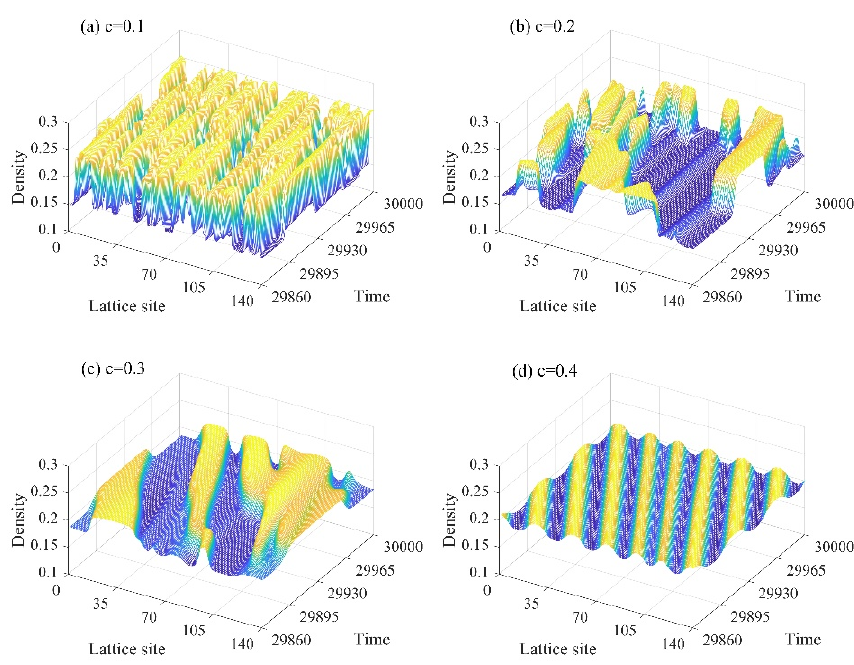
Figure 7 Figure 4. Space–time evolution of density under different value of parameter c .